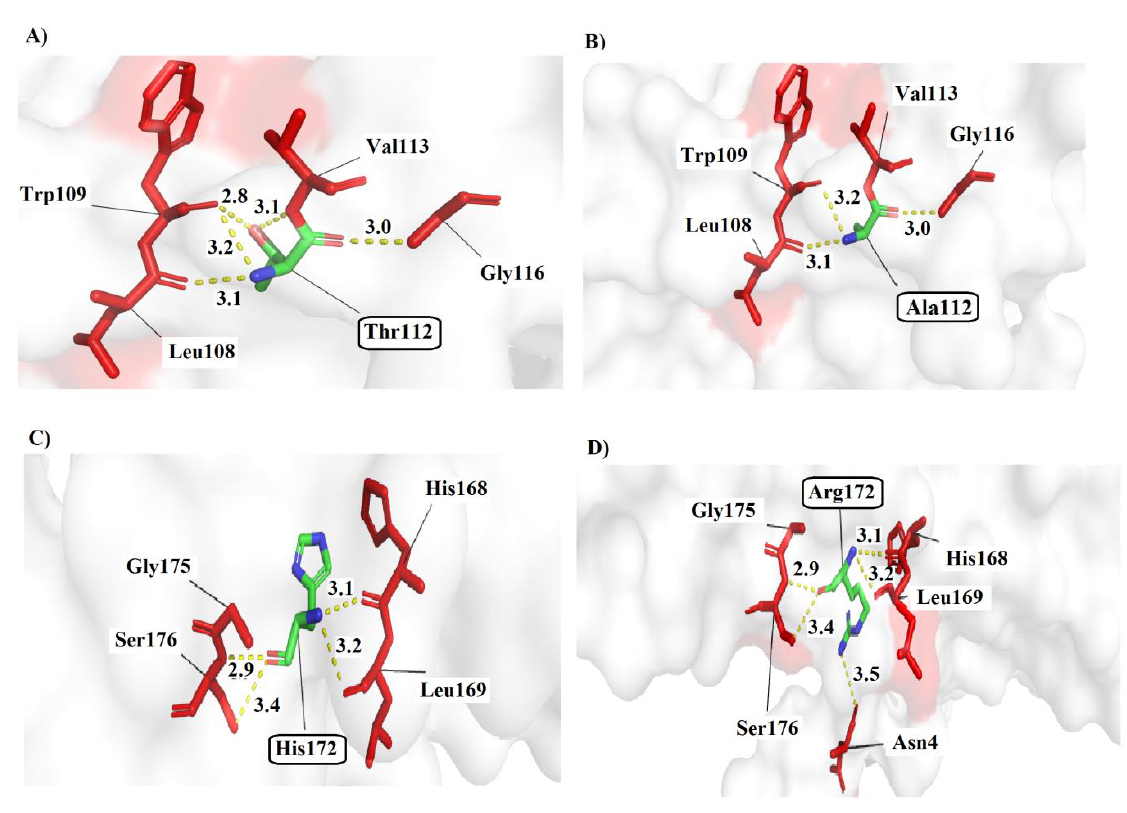
Figure 8: Three-dimensional structure model predictions for normal and mutant variants; A, B ) Thr112 (Normal) and Ala112 (mutant), C, D ) His172 (Normal) and Arg172 (mutant) in ATPase6 by PyMol